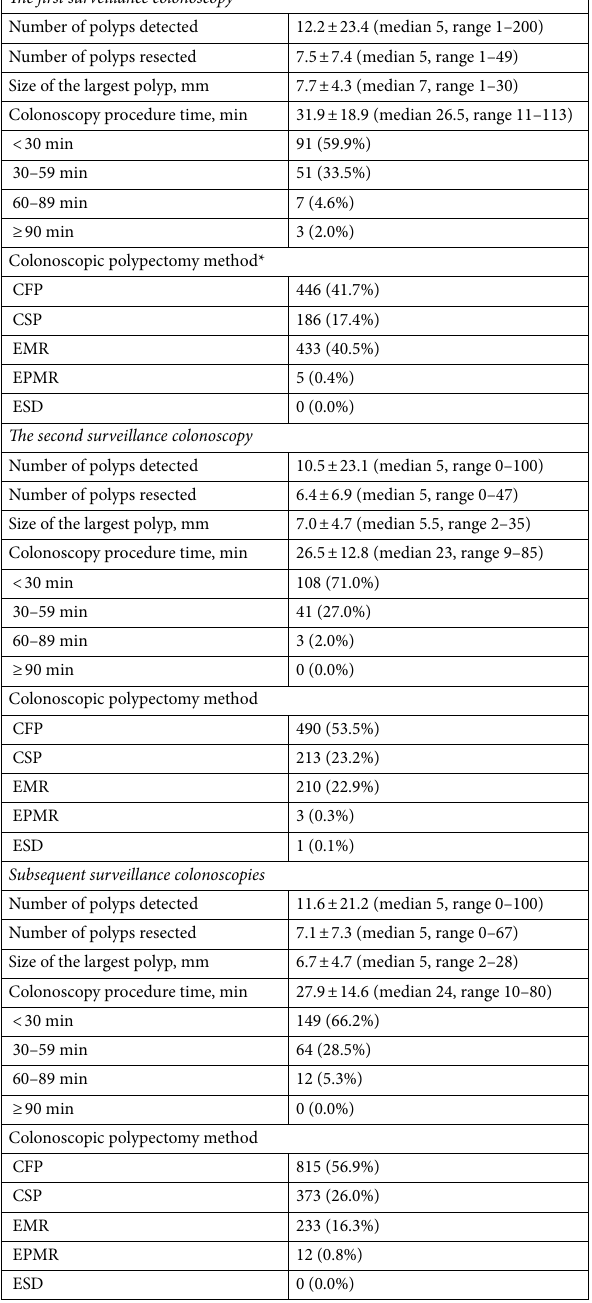
Table 3. Surveillance colonoscopy findings. Data are presented as n (%) or mean ± standard deviation with median and range. CFP cold forceps polypectomy, CSP cold snare polypectomy, EMR endoscopic